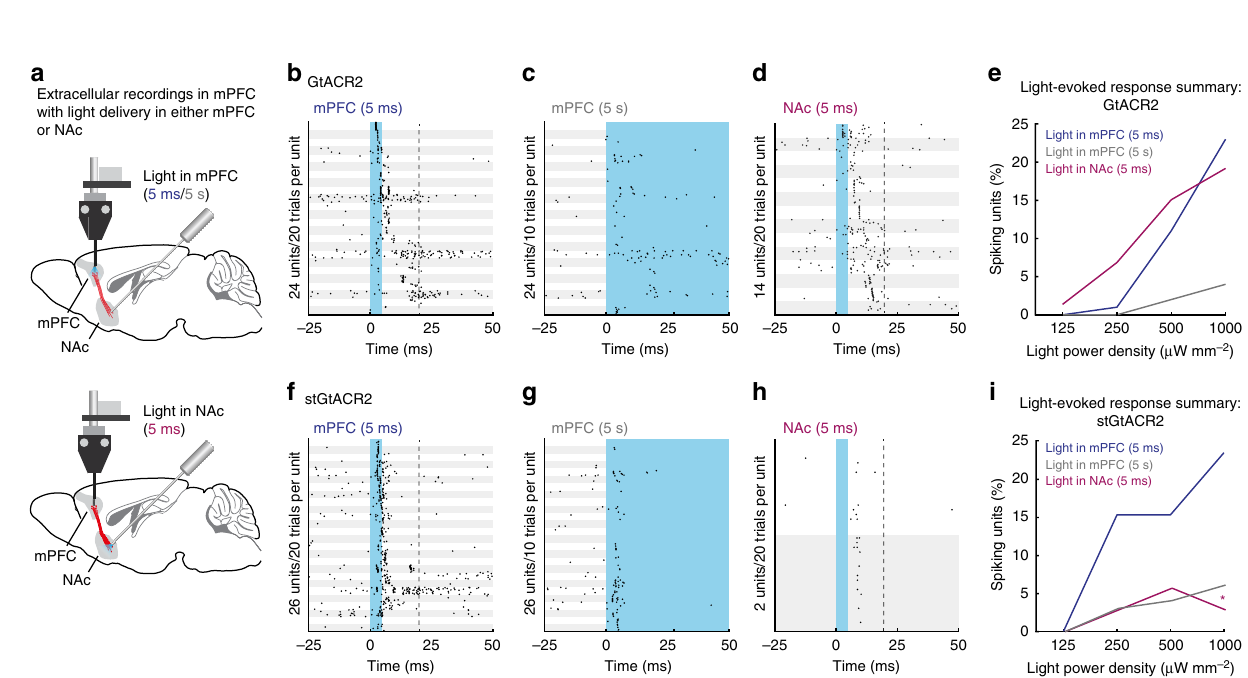
Fig. 6 Targeting GtACR2 to the somatodendritic compartment attenuates antidromic spiking in distal axons. a Schematic of experimental paradigm (adapted with permission from 68 ), performed in the same mice depicted in Fig. 5. Extracellular recordings from the mPFC were performed with a movable optrode following AAV-mediated GtACR2 or stGtACR2 expression in the mPFC. Antidromic spiking was characterized in response to mPFC or NAc illumination (460 nm; mPFC − 5 ms and 5 s pulses; NAc − 5 ms pulses). Four light power densities were tested. b – d Raster plots of light